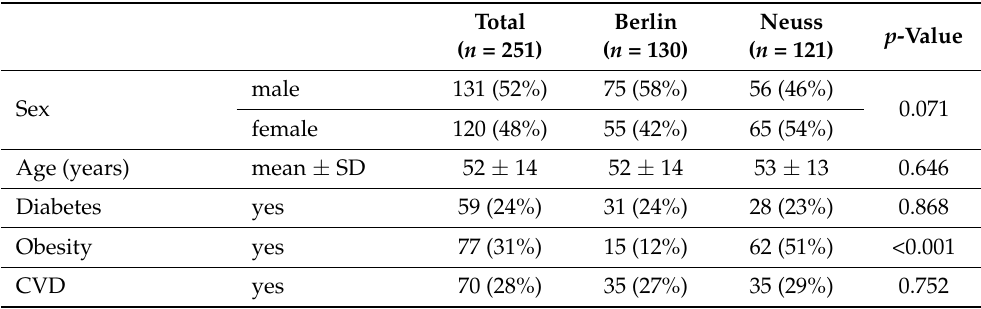
Table 1. Demographic parameters, comorbidities and details concerning dialysis-dependency com- paring both